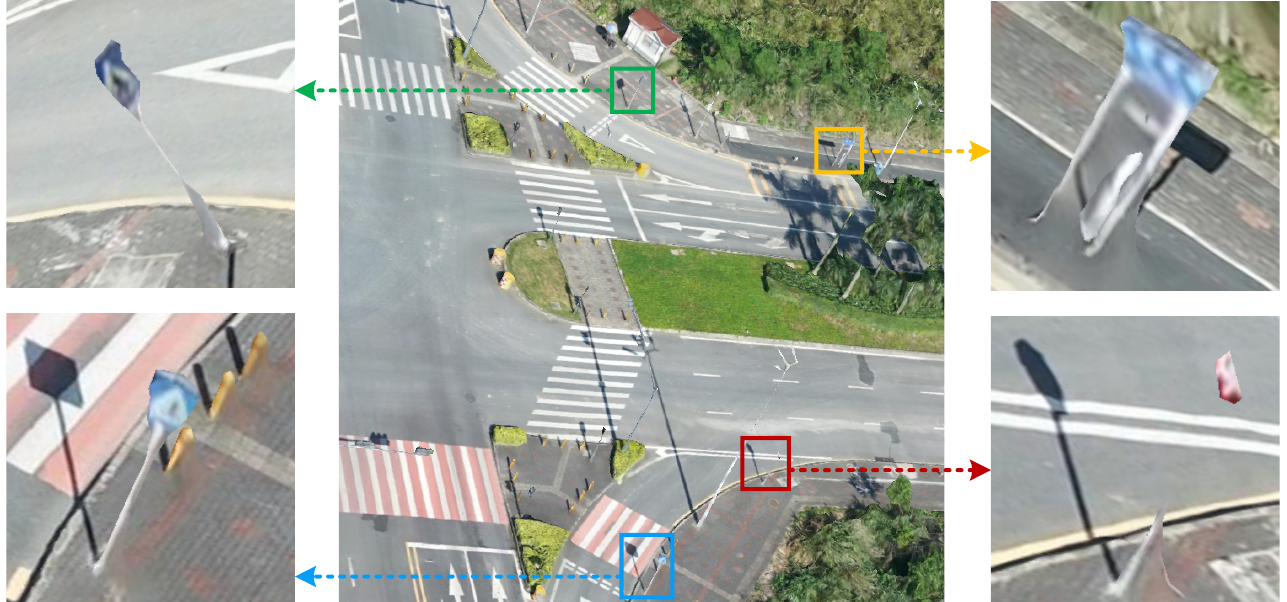
Figure 1. Examples of road sign models reconstructed via the software ContextCapture in urban scenes.